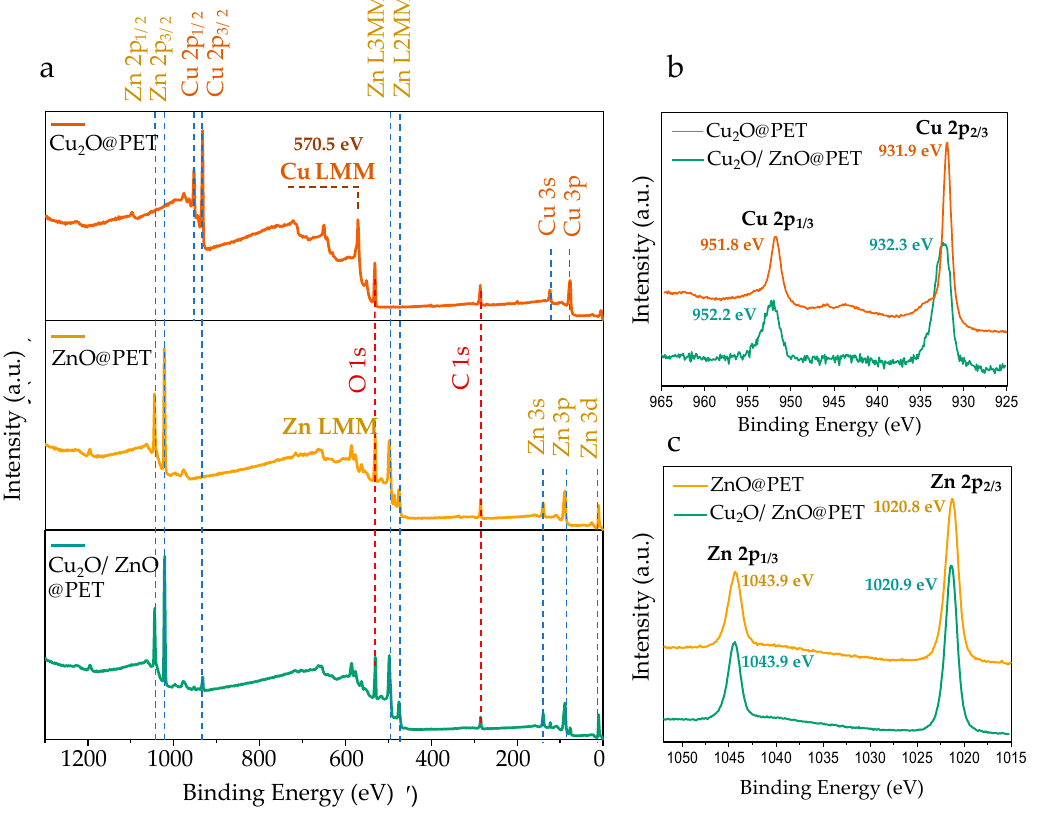
Figure 5. ( a ) Wide-scan XPS spectra of Cu 2 O@PET, ZnO@PET and Cu 2 O/ZnO@PET membranes. ( b ) Comparison of core-level Cu 2p XPS spectra of Cu 2 O@PET and Cu 2 O/ZnO@PET. ( c ) Comparison of core-level Zn 2p XPS spectra of ZnO@PET and Cu 2 O/ZnO@PET.